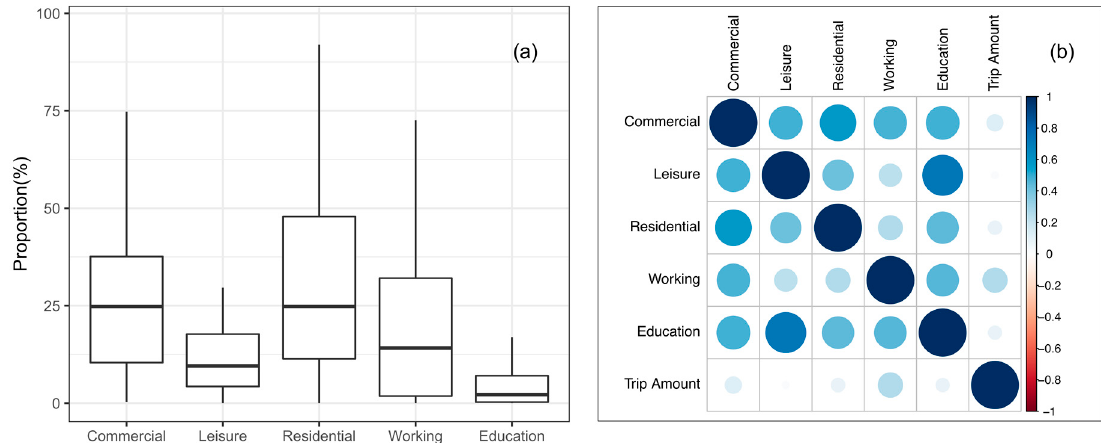
Figure 3. ( a ) Distribution of the proportions of check-ins at different categories of POIs in metro service catchment; ( b ) correlation between POI check-ins and metro station trip amount.